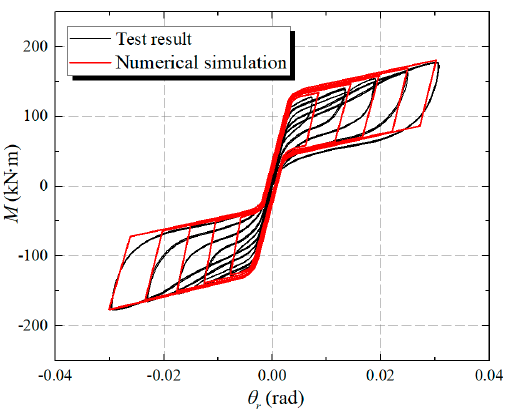
Figure 5. Comparisons of hysteretic behavior of numerical simulation and test results.